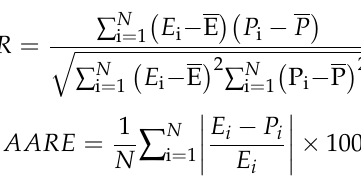
Figure 11. Comparison of predicted and corrected stress at different temperatures: ( a ) 750 ◦ C, ( b ) 850 ◦ C, ( c ) 950 ◦ C, ( d ) 1050 ◦ C, ( e ) 1150 ◦ C; ( f ) linear